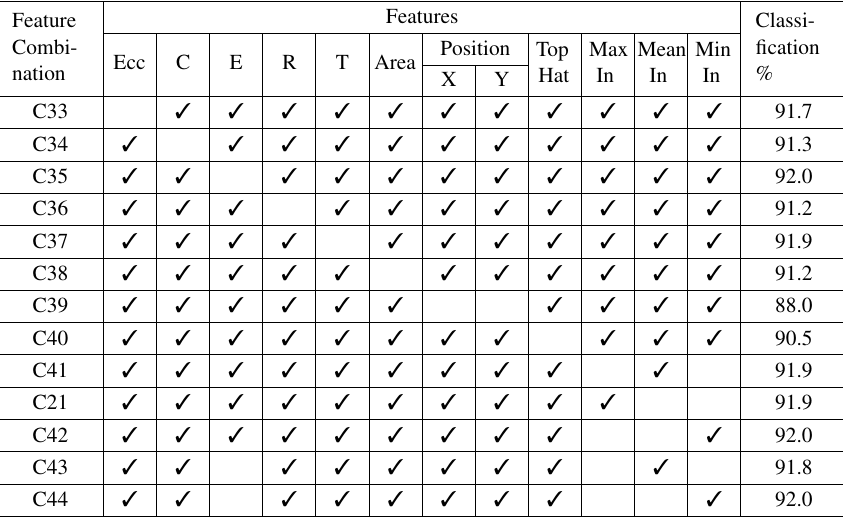
(cid:15) the maximum horizontal distance between the two spots is 114